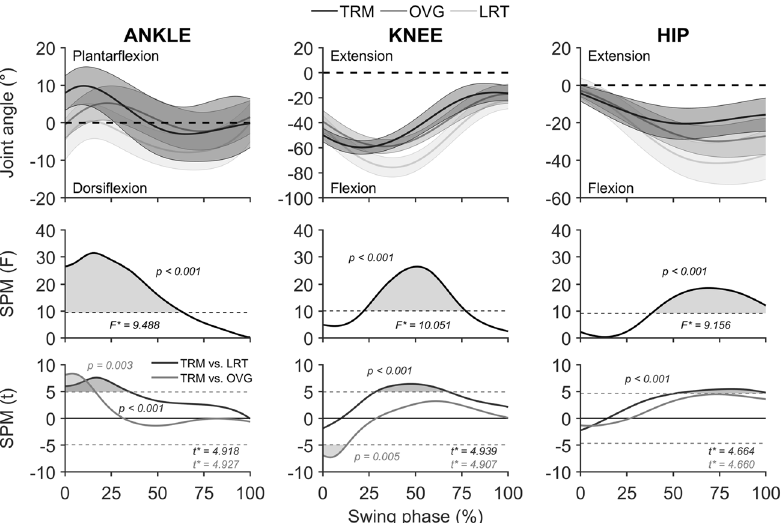
Figure 5. Sagittal plane joint angle kinematics for the high perturbation magnitude group ( n = 10) and statistical parametric mapping (SPM) analyses of the ankle, knee, and hip joint. Graphs show the entire swing phase of the recovery step (toe-off to touchdown, 0-100%) for the eighth treadmill-based trip (TRM), overground trip (OVG) and lean-and-release (LRT). First row : Joint angle comparisons for all three tasks (bold lines as averages and shaded areas as standard deviations). Second row : SPM one-way repeated measures ANOVA [SPM( F )] and univariate F -statistic ( F *) with significance threshold at 99% confidence (dashed line) with task as factor (TRM, OVG and LRT). The shaded areas indicate significant amongst the three tasks. Third row : post-hoc tests [SPM( t )] comparing pairs of joint angle curves (i.e. TRM vs. LRT in black and TRM vs. OVG in grey). t -statistic ( t *) with significance threshold at 99% confidence (dashed lines) and shaded areas indicating significant differences between the pairs of